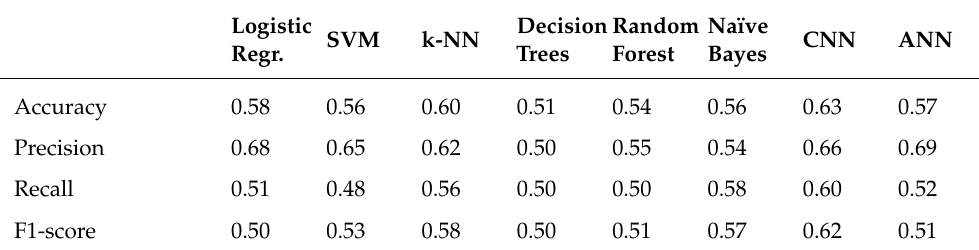
Table 7. The performance metrics of the “3 × 3 + IM ” reduced confusion matrix for each applied al-